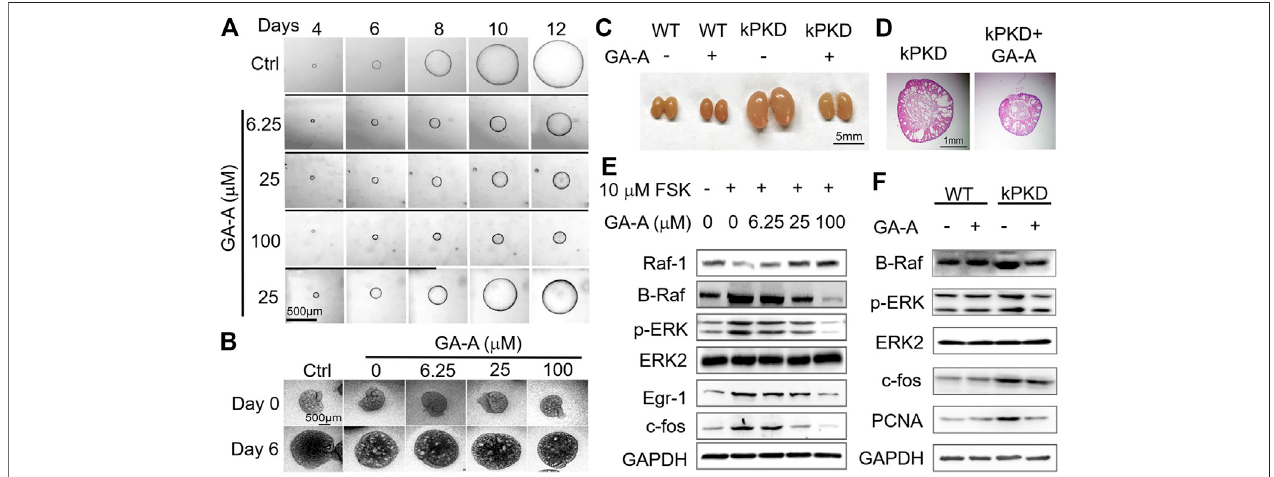
FIGURE2| InhibitionofGA-Aonthegrowth ofcystsinADPKD. (A) RepresentativelightmicrographsofMDCK cystsincollagengel from4thto12thday thatwere untreated or treated with GA-A at different concentrations. The fi rst row, as the control group, was given only FSK stimulation for 12 days; the second, third, and fourth rows were given FSK and 6.25, 25, 100 μ M GA-A co-stimulation from the 5th to 12th day, respectively. In the fi fth row, FSK and 25 μ M GA-A were co-stimulated from the fi fth to eighth day, and the GA-A was washed out from the 9th to 12th day with only FSK. The thick black lines indicate the culture time with GA-A. Scale bar (cid:2) 500 μ m. As the concentration of GA-A increases, the inhibitory effect on cyst growth was more obvious. The cyst growth could be restored after removal of GA-A, indicating that the inhibitory effect of GA-A on cyst growth is reversible. (B) Representative graphs of inhibitory effect of different doses of GA-A on mouse embryonic kidney cysts on day 0 and day 6. Embryonic kidneys were cultivated as the negative control (Ctrl) without 100 μ M 8-Br-cAMP or exposed to different GA-A concentrations in the presence of 100 μ M 8-Br-cAMP. Scale bar (cid:2) 500 μ m. Results showed that GA-A also inhibited the cyst development at the organ level and the inhibitory effect showed a certain dose-effect relationship. (C) Mouse kidneys from wild-type (WT) mice and kPKD mice on postnatal day 4 were treated with vehicle or 50 mg/kg/d GA-A for4 days. Scale bar (cid:2) 5 mm. Compared withWT mice, the kidney volumes ofkPKDmicewere signi fi cantlyincreased, and GA-A effectively inhibited the kidney volumes of kPKD mice with no obvious effect on the kidney volume of WT mice. (D) Hematoxylin and eosin staining of kidneys in vehicle- or GA-A-treated kPKD mice. Scale bar (cid:2) 1 mm. The kidney of kPKD mice had obvious cystic structure, and normal tissue structure of the kidney was destroyed. The cyst growth in the kidney of kPKD mice treated with GA-A was effectively slowed. (E) Representative Western blotting of signaling proteins in MDCK cells treated with 10 μ M FSK and without or with GA-A at different concentrations for 30 min. Results demonstrated that GA-A downregulating the Ras/MAPK signaling pathway in the FSK-treated MDCK cells. (F) Representative Western blotting of signaling proteins in mouse kidneys without or with GA-A